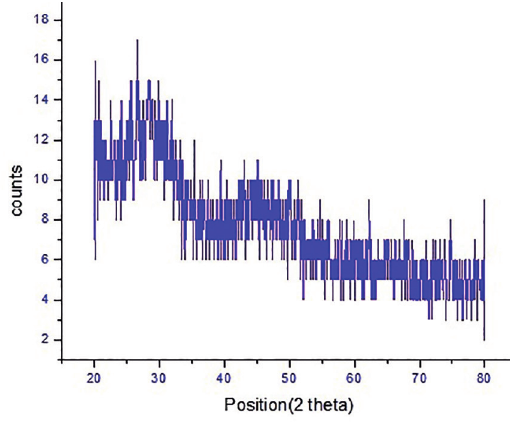
O (x=10 % and x 1 = 2 5 Figure 3: Emission spectrum of Pr doped borate glass.